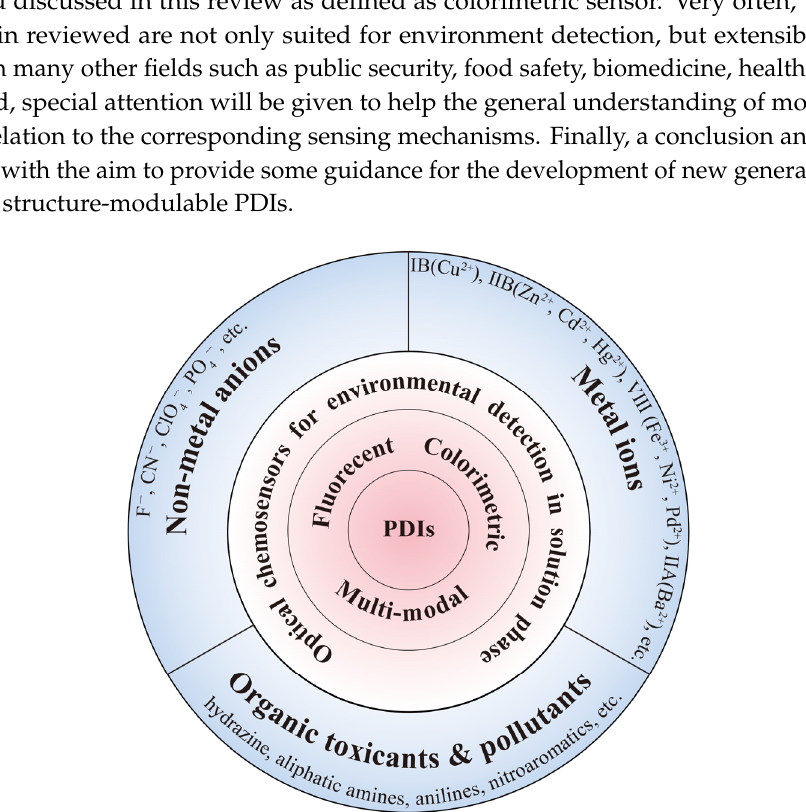
Figure 1. Schematic illustration of main applications of PDI-based optical chemosensors in liquid environmental detection.